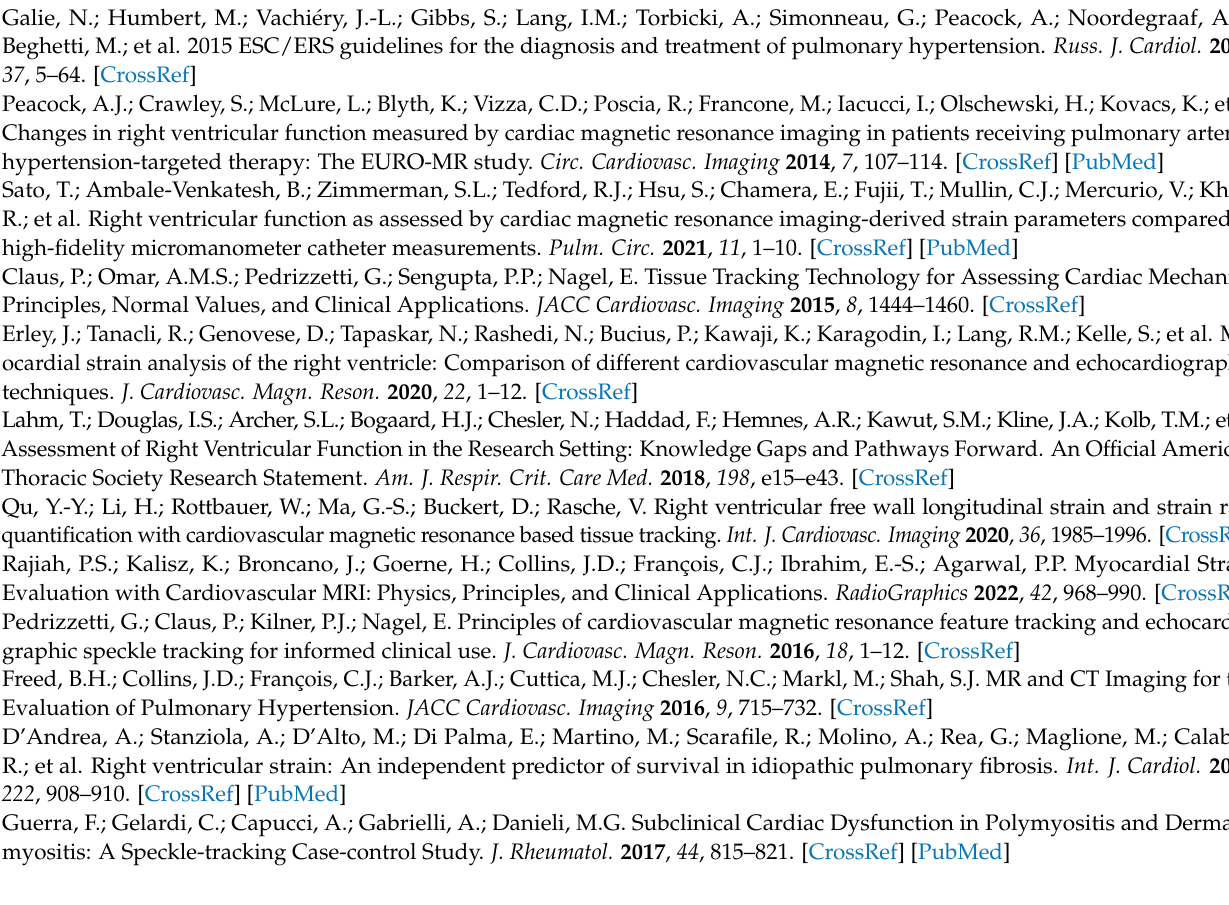
Figure S3: Ees over Ea quartiles before PEA under high loading conditions; Figure S4: Scatter GLS EDVi Ratio vs.